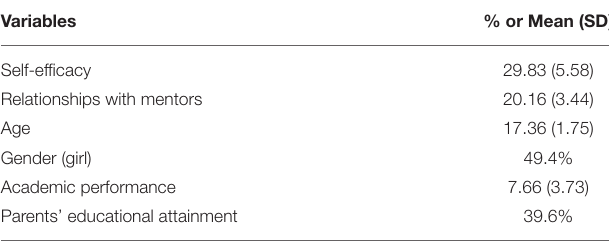
TABLE 1 | Descriptive statistics.